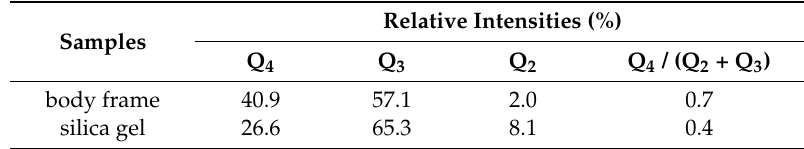
Table 3. Relative intensities of Q n species.